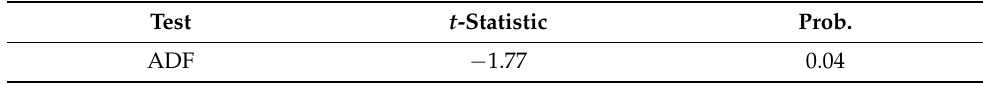
Table 6. KAO Cointegration